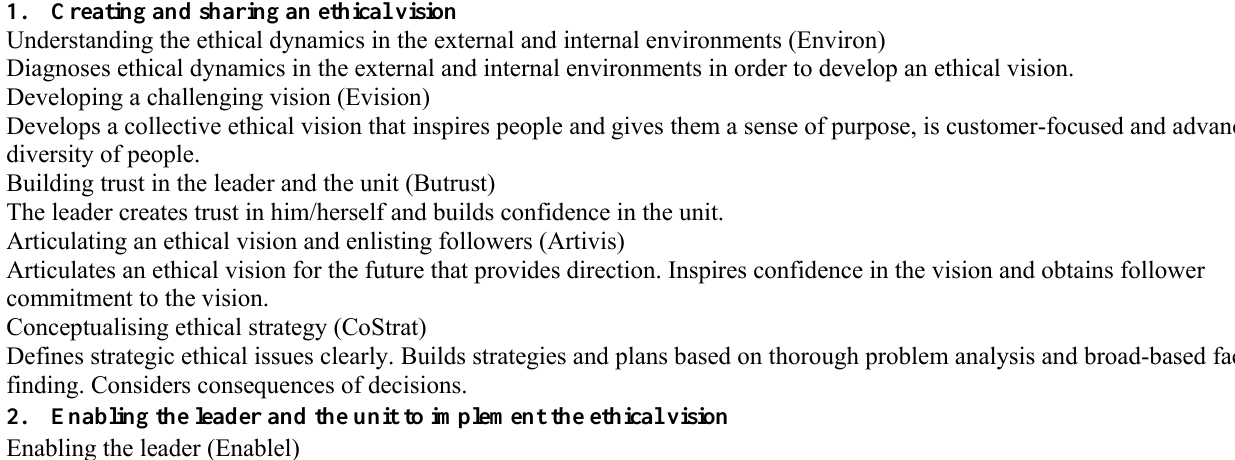
Table 1: First-order latent leadership dimensions measured by the ELI